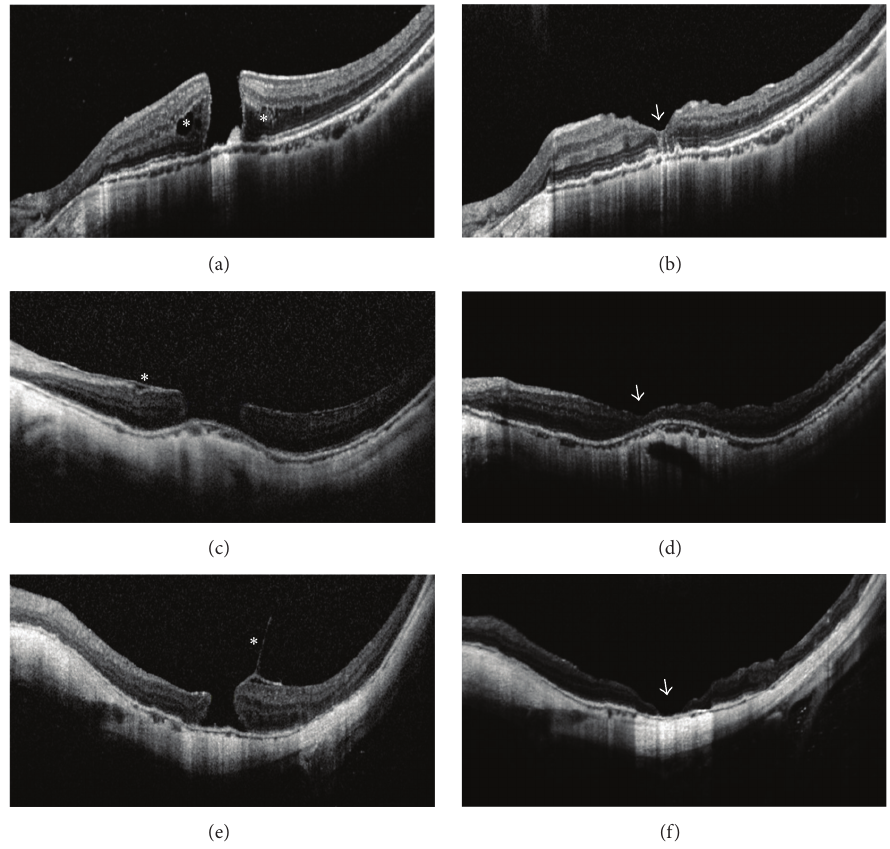
Figure 2: Optical coherence tomography (OCT) images of large myopic macular holes (MHs) in selected cases before and after surgery. (a) Case Number 5 before surgery. An MH of 563 𝜇 m and retinoschisis around the MH (asterisks) was present. Best-corrected visual acuities (BCVAs) = 0.02. (b) Case Number 5 at 6 months after surgery. Type 1 closure in U-shape and restoration of the inner and outer segment junctionlinewasachieved(arrowhead).BCVA=0.3.(c)CaseNumber12beforesurgery.Alarge-sizedMHof812 𝜇 mandepiretinalmembrane (asterisk) was present. BCVA = FC/50cm. (FC = finger counting) (d) Case Number 12 at 6 months after surgery. Type 1 closure in shallow V-shape was present (arrowhead). BCVA = 0.3. (e) Case Number 14 before surgery. A longstanding MH of 491 𝜇 m and vitreomacular traction (asterisk) was present. BCVA = HM/BE. (HM = hand motion; BE = before eye) (f) Case Number 14 at 6 months after surgery. Type 2 closure with bare retinal pigment epithelium in the center (arrowhead) was present. BCVA =